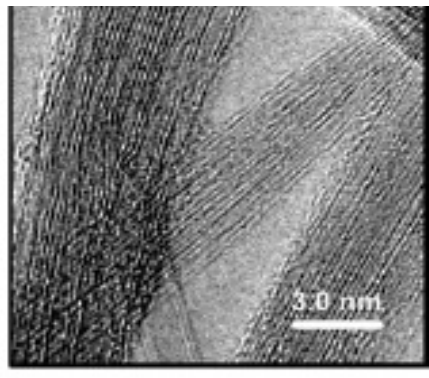
Figure 6. TEM of DWCNTs. Adapted from reference [16], with permission from Elsevier . Dai, H, Rinzler, A.; Nikolaev, P.; Thess, A.; Colbert, D.; Smalley R. Single-wall